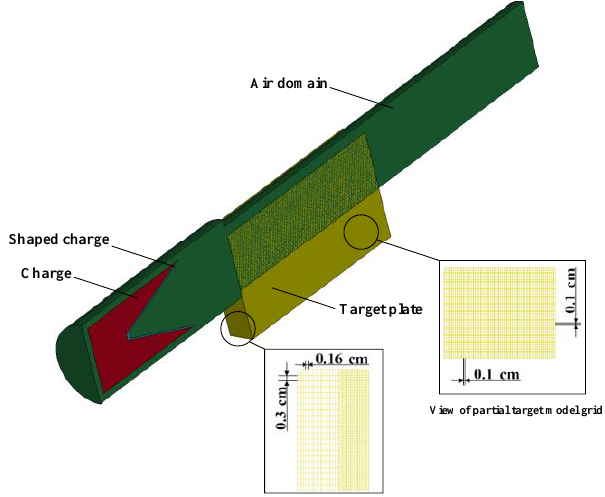
Figure 7. Schematic representation of the numerical simulation model.